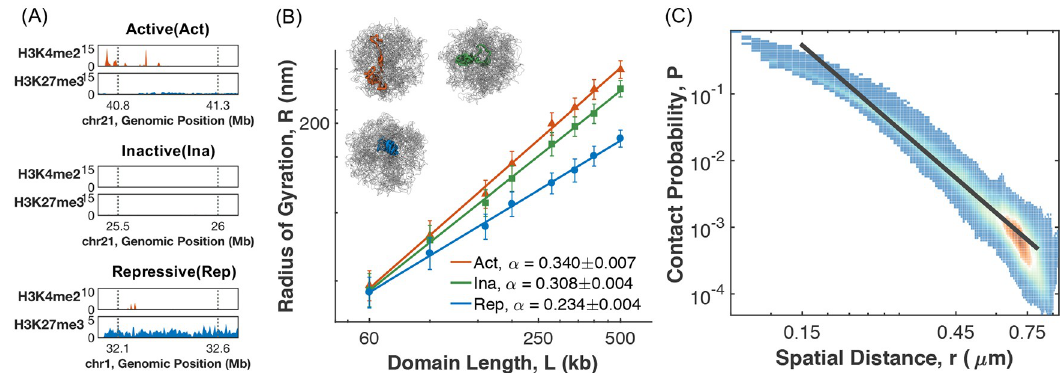
Fig 4. Simulated chromatin structures reproduce findings from super-resolution microscopy experiments. (A) Characteristic histone modification profiles for repressive, active and inactive chromatin. (B) The sizes of repressive (blue), active (orange) and inactive (green) chromatin domains, as measured by their radiuses of gyration, are plotted as a function of the genomic separation on a log scale. The straight lines correspond to numerical fits of the data with a power-law expression R = R o L α , with the values of α shown in the legend. Representative structures of 500kb in length for the three chromatin types are shown in the inset. Error bars correspond to standard deviations of structures from the entire simulated ensemble. (C) Scatter plot of the contact probabilities between pairs of genomic loci versus their spatial distances shown on a log-log scale. The black line is the best fit to the data using the expression P = P o r β , with β = − 4.18.